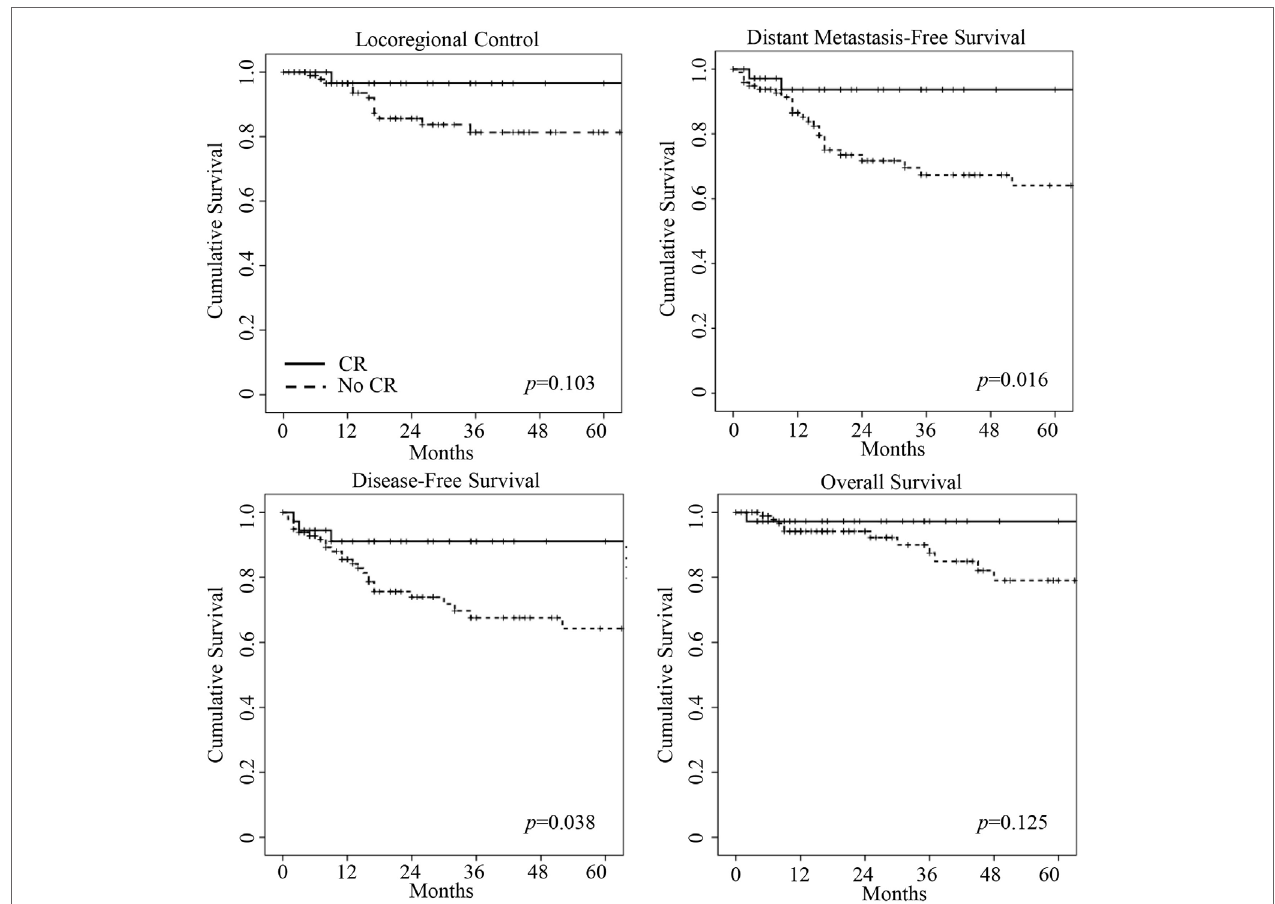
FigUre 1 | Kaplan–Meier curves of locoregional control, distant metastasis-free survival, disease-free survival, and overall survival for complete response (cr) patients (bold line) and no complete response (no cr) patients (dashed line) . CR patients had longer distant metastasis-free survival and disease-free survival on log-rank test ( p values shown in